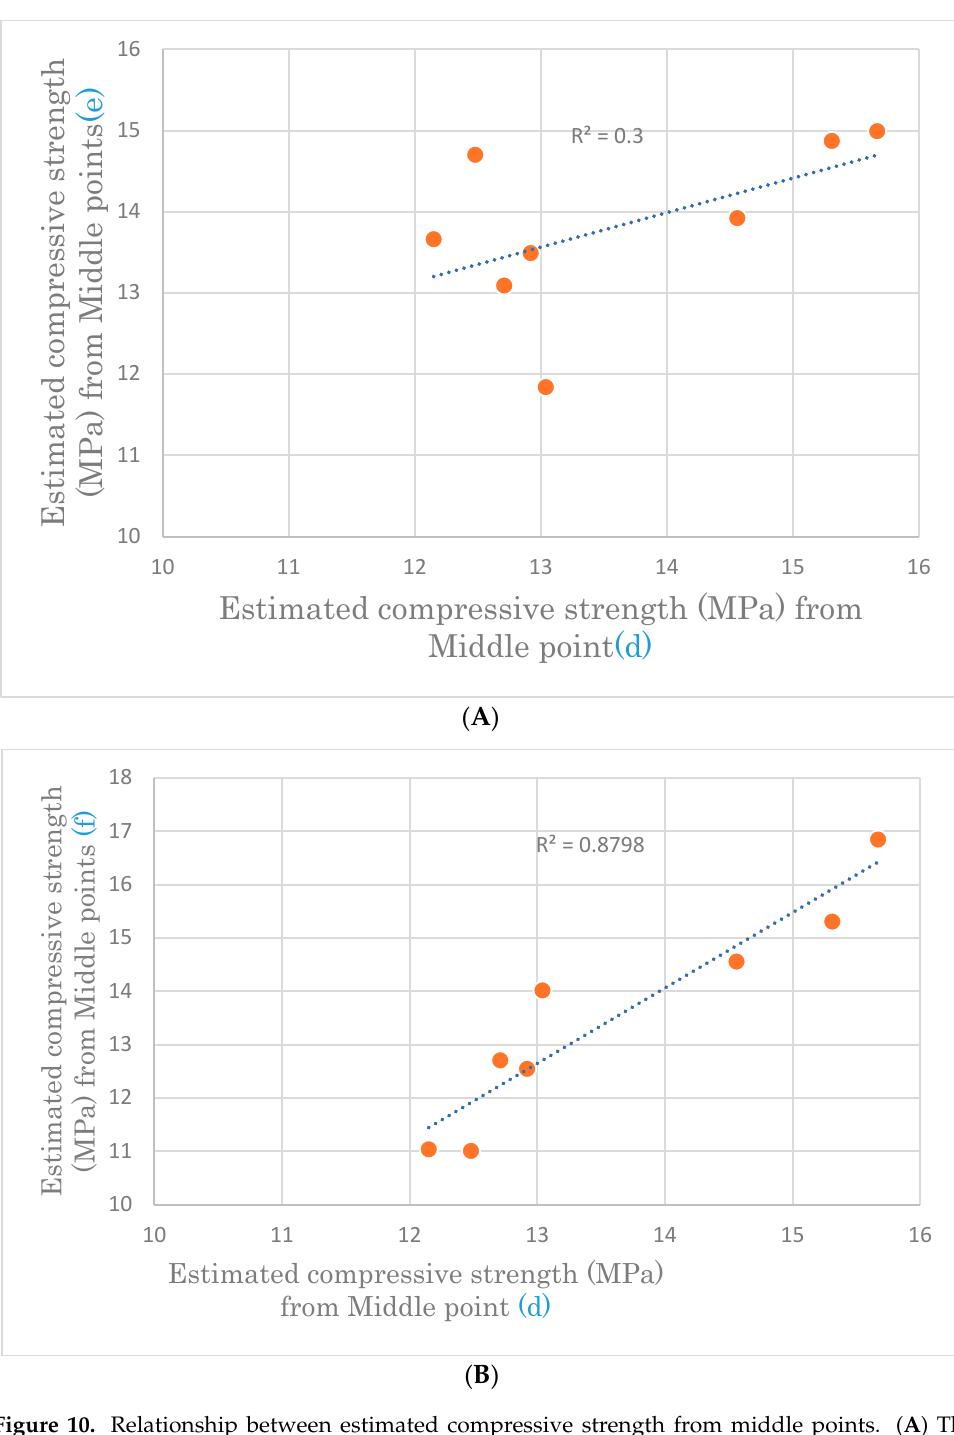
Figure 9. Multiple compressive values by specimen.